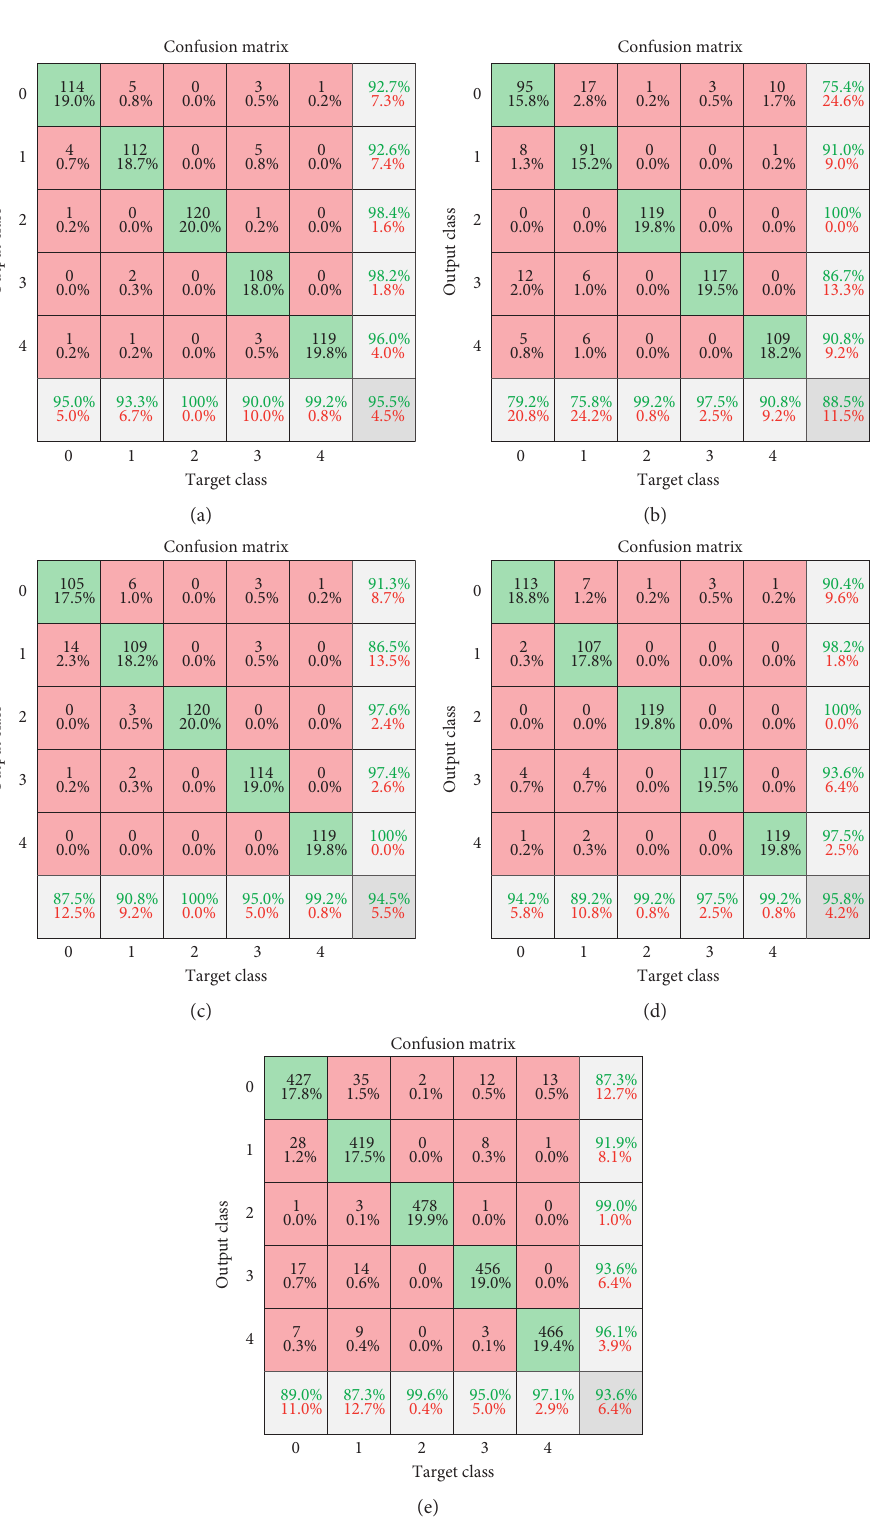
Figure 7: Confusion matrix for CNN-S. (a) Condition 1. (b) Condition 2. (c) Condition 3. (d) Condition 4. (e) Statistics of all single